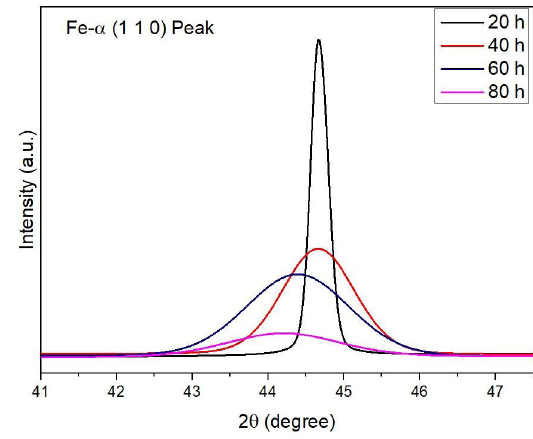
Figure 17. Detail of the (110) Fe-α peak analysis due to different milling times for Fe-15at.%Nb samples with stearic acid PCA.